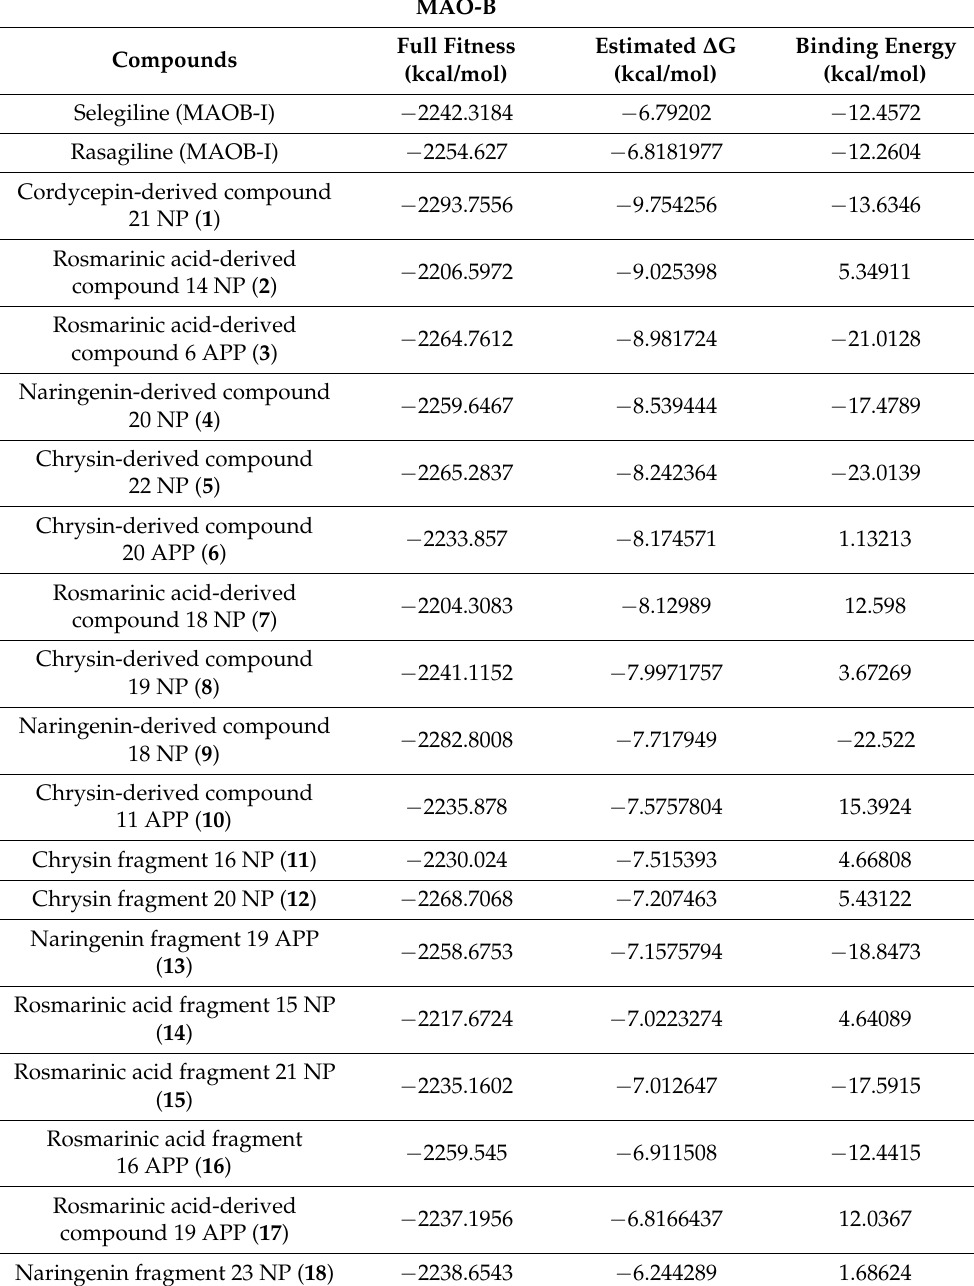
Table 1. Docking test for evolutionary library compounds against the